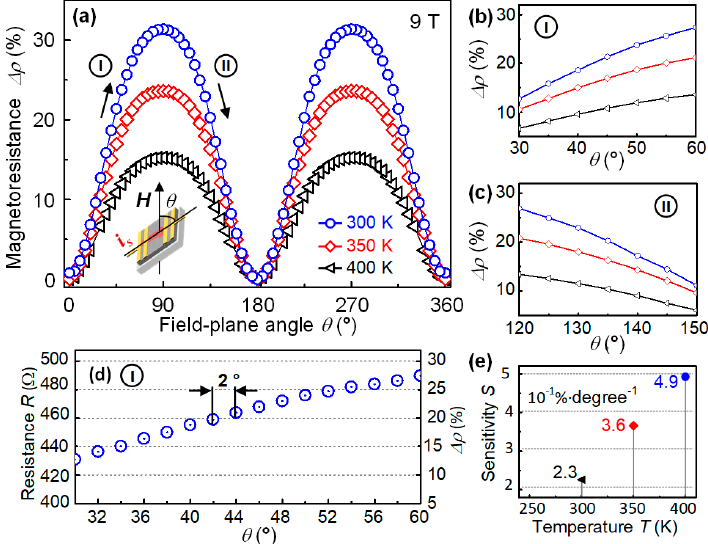
Figure 3. Magnetic sensing property of carbon film in external magnetic field with different plane-to-field angle θ . ( a ) Temperature dependent anisotropy magnetoresistance from 300–400 K. The intensity of the external field was 9 T, θ changed from 0 ° to 360 ° as sample rotated along axis perpendicular to magnetic line and current direction, as illustrated inside the figure; ( b )–( c ) near-linear AMR response in the range θ of 30 ° –60 ° , and the temperature dependency; ( d ) resistance and magnetoresistance in the angle range of 30 ° –60 ° at 300 K, with increment of 2 ° , implying that the finest resolution can reach 2 ° ; ( e ) calculated sensitivity at different temperatures from ( b ) and ( c ).